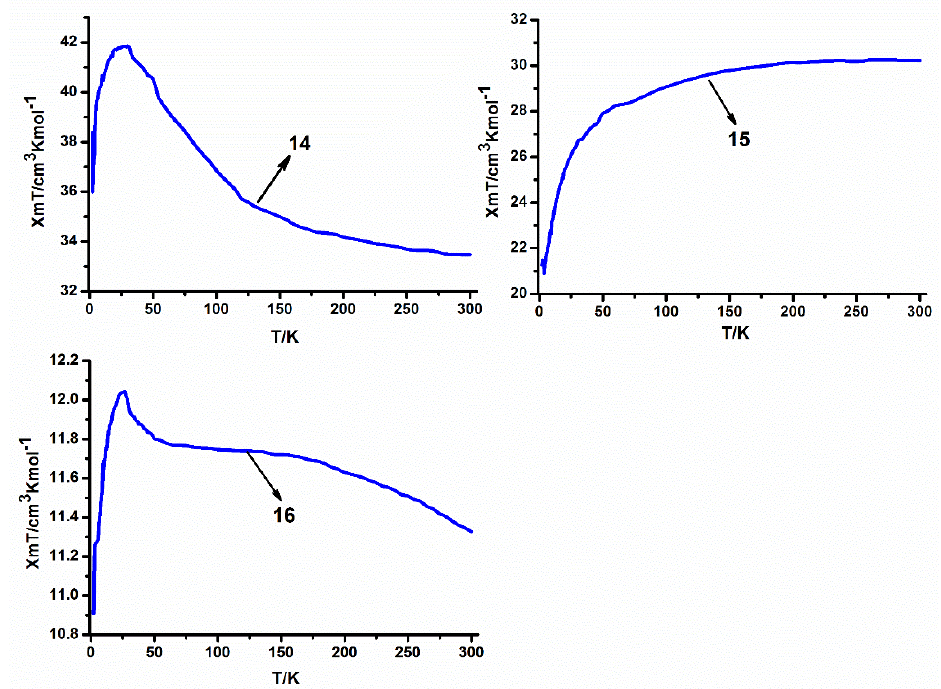
Figure 10. Temperature dependence of the χ m T curves at 1000 Oe for the series of heteropentanuclear compounds 14 – 16 .